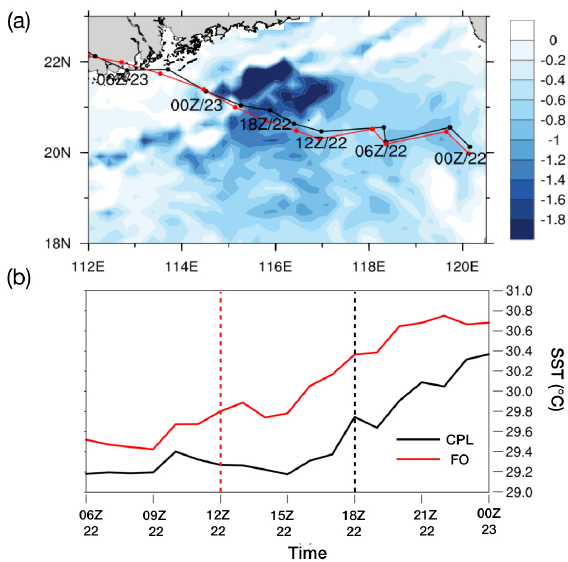
Figure 4. SST changes in the air–sea coupled model and the comparison of inner-core area averaged SST in two simulations ( ◦ C). ( a ) SST difference between 0600 UTC 23 August and 0000 UTC 22 August, on which the black line with dots indicates the CPL simulated TC trajectory while the red one is for the FO simulation. The numbers by the path are same with Figure 3. ( b ) The hourly local SST changes with time averaged in an area of 60 km radius from the storm center. The abscissa values indicates the time of day. Black line is for the CPL experiment and the red one denotes the FO storm, overlaying the RI onset time in two experiments shown in dash lines.